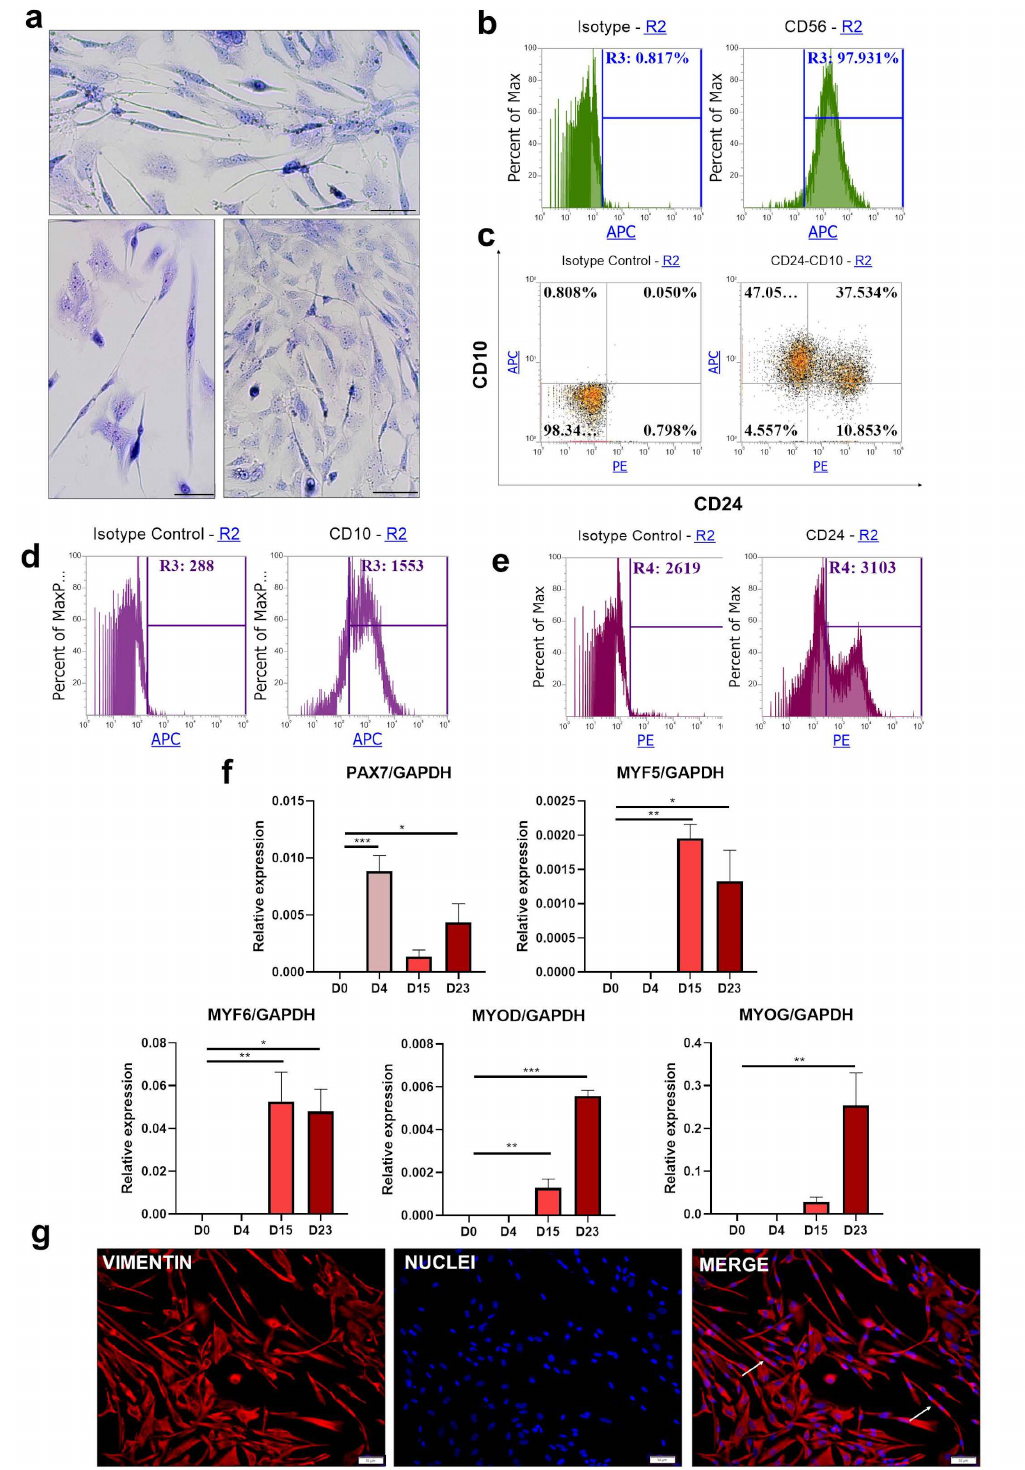
Figure 4. Differentiation of iPS cells into skeletal muscle cells with Protocol III: ( a ) morphology of the cells visualized with Wright’s staining on day 23 of the experiment. Scale bar represents 50 µ m. ( b ) representative results of flow cytometry analysis of CD56 expression on day 23; ( c ) double staining for CD10 and CD24 expression analyzed with flow cytometry on day 23, representative result; ( d ) analysis of the total CD10 + mean fluorescence intensity on day 23, representative result; ( e ) analysis of the total CD24 + mean fluorescence intensity on day 23, representative result; ( f ) qPCR analysis of myogenic gene expression during the differentiation, n = 3 or 4, * p < 0.05, ** p < 0.01, *** p < 0.001; ( g ) vimentin and cell nucleus immunofluorescence staining at the end of the experiment. Scale bar represents 50 µ m; white arrows indicate cell